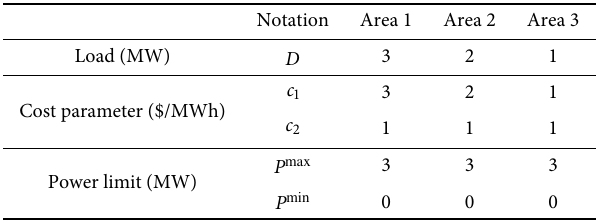
Table 1 Parameters of generators and loads in each area